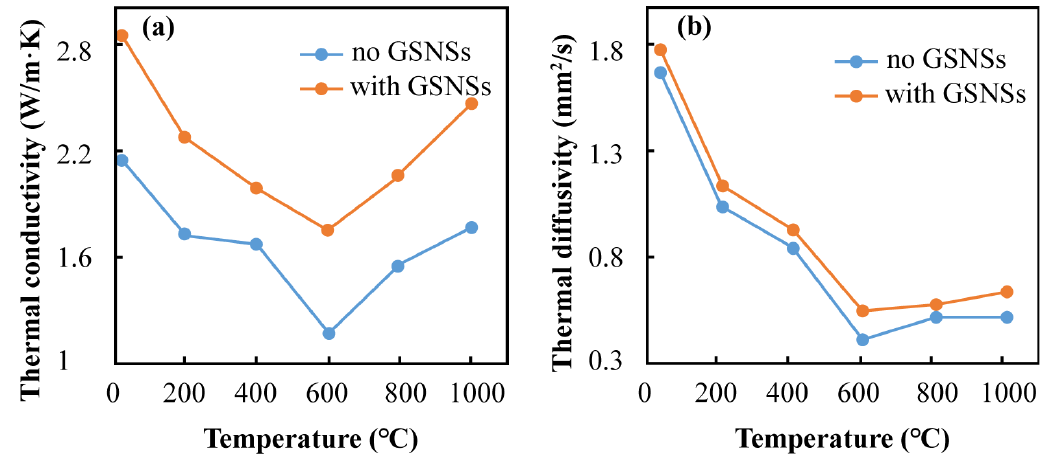
Figure 15: (a) Thermal conductivity and (b) thermal diffusivity of concrete at ambient temperature (25 ∘ C) and during exposure to high temperatures [153] Table 3: Effect of carbon nanomaterials on the durability of cement-based materials